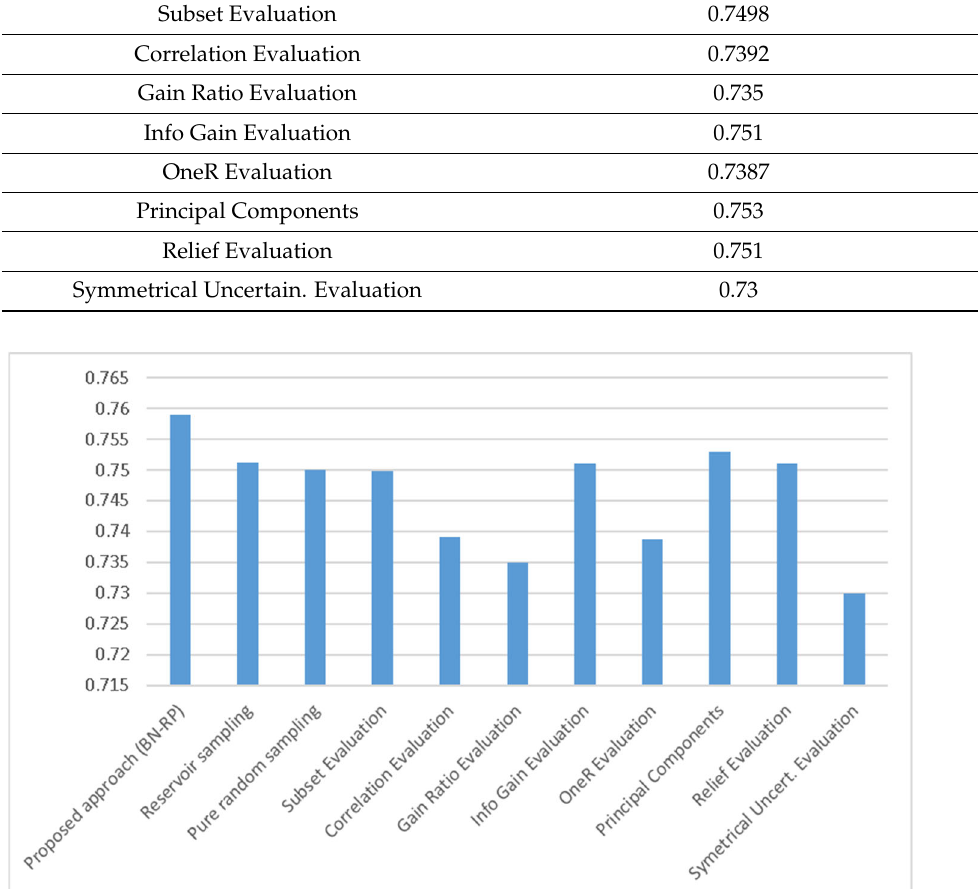
Figure 11. Comparison of the proposed approach with feature/data selection approaches.